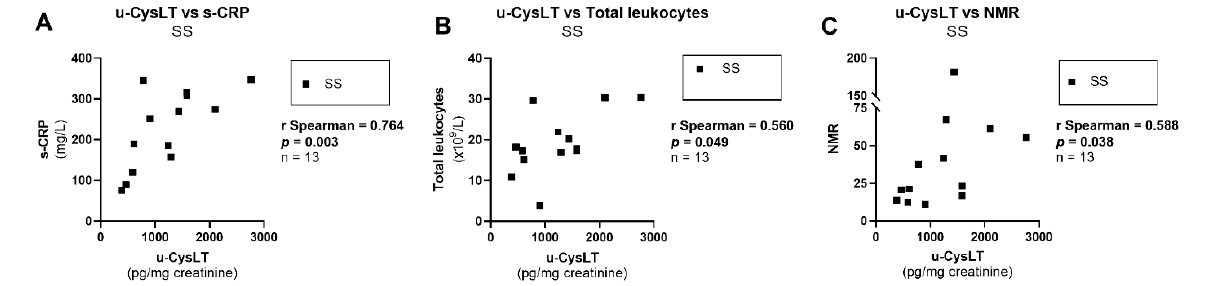
Figure 7. Correlations between u-CysLT and routine clinical inflammatory markers/parameters at admission in SS patients: ( A ) u-CysLT vs. s-CRP; ( B ) u-CysLT vs. total leukocytes; ( C ) u-CysLT vs. NMR; NMR, neutrophil-to-monocyte ratio; u-CysLT, urinary cysteinyl leukotrienes. The values of u-CysLT were corrected for the respective urinary creatinine concentrations.